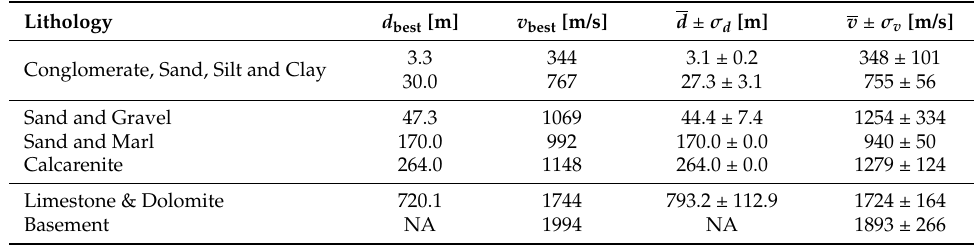
Table 4. Well-log lithology and HVSR inversion final Vs models from the EJDN station are summa- rized for data obtained by FFT. The best model (depth, d best , and Vs, v best ), and the mean model with standard deviation (depth, d ± σ d , and Vs, v ± σ v ) are